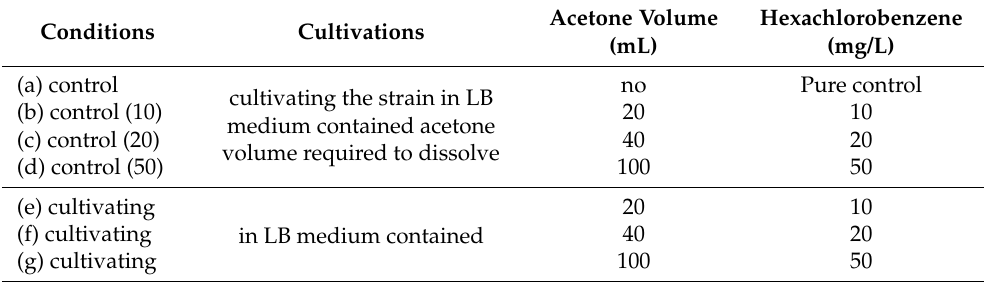
Table 1. Cultivation conditions of Comamonas testosteroni strains in a mineral medium LB with the HCB